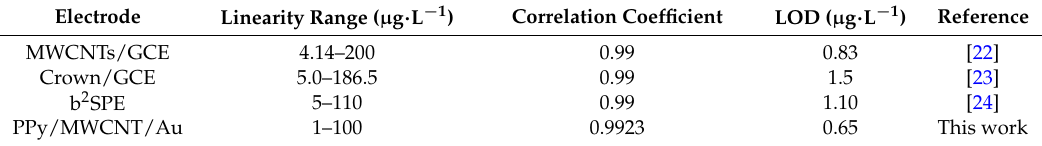
Table 1. Electrode performance for measuring Pb 2+ .